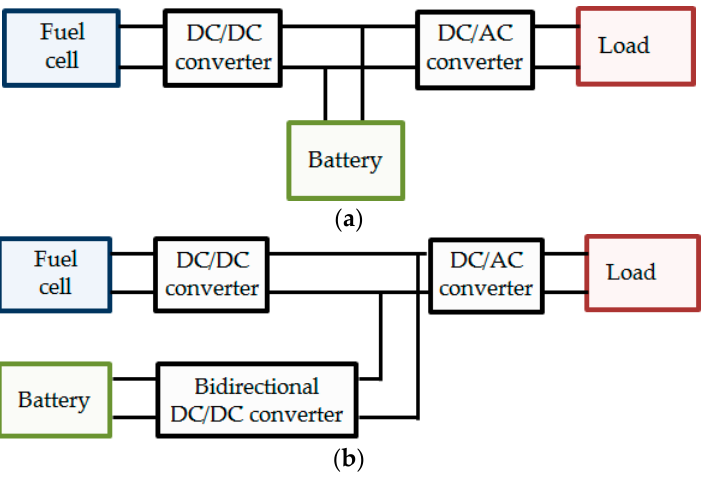
Figure 5. Interfacing fuel cell and power storage parameters: ( a ) series; ( b ) parallel.